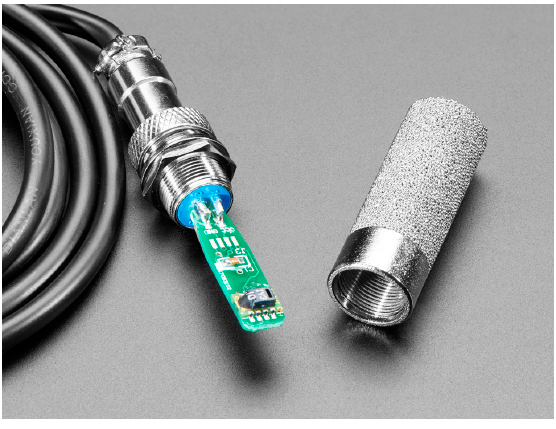
Figure 11. SHT15 sensor.